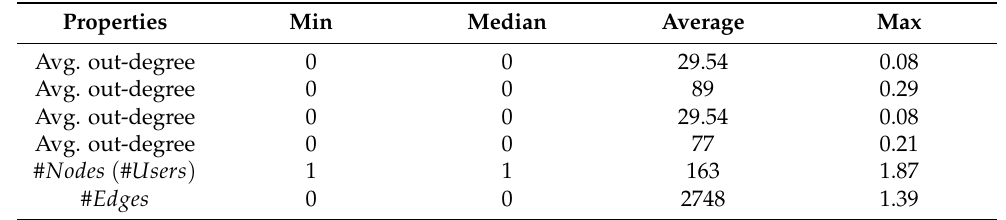
Table 3. Graph structural statistics of social networks constructed from tweet cascade in